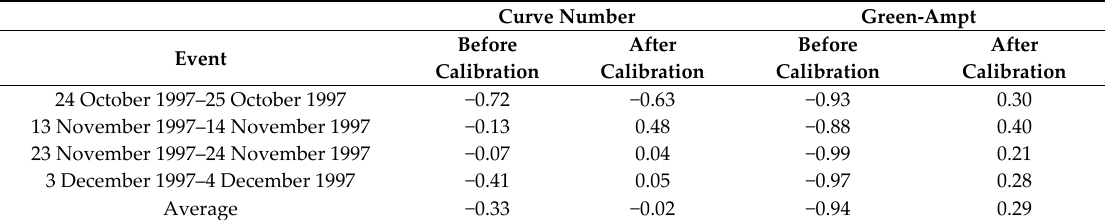
Table 4. Relative error in simulating runoff volume with Curve Number and Green-Ampt methods for the four selected events and average